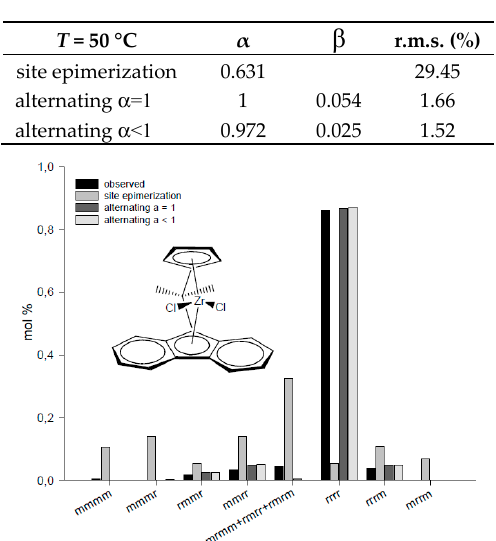
Figure 3. Statistical pentad analysis of a polypropene sample prepared with 5 /MAO at 50 °C .